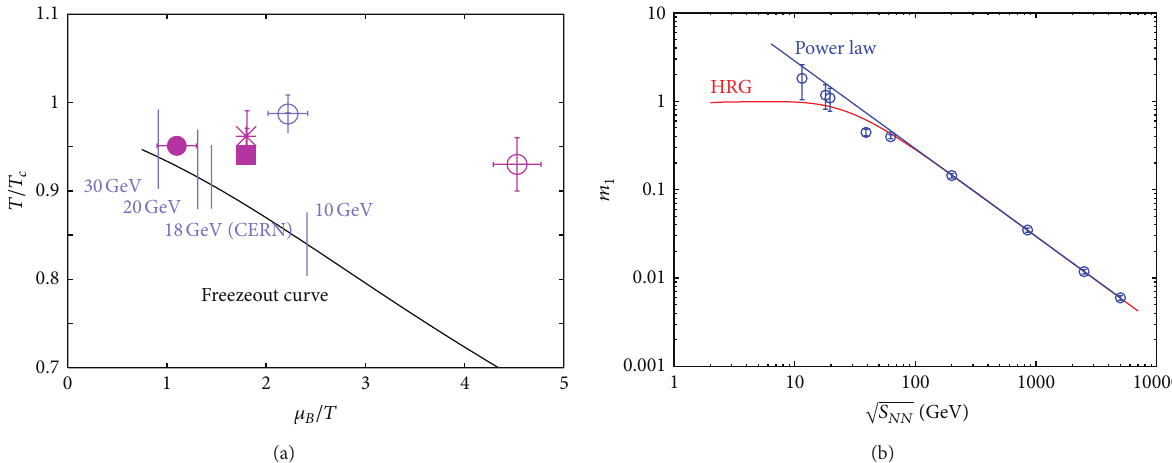
Figure 16: The estimates of the critical point from lattice studies are shown in (a), from [137]. The magenta solid circle, box, and star denote the 𝑁 𝜏 = 4,6, 8 data, respectively, for 2 flavours of staggered quarks [135–137], and the open circles denote 𝑁 𝜏 = 4 data for 2 + 1 flavours obtained with reweighting techniques [87, 133]. In (b), the ratio of the third and the second order baryon number susceptibility is plotted as a function of √𝑠 relevant for the RHIC and LHC experiments and compared with the HRG model data, from [108].